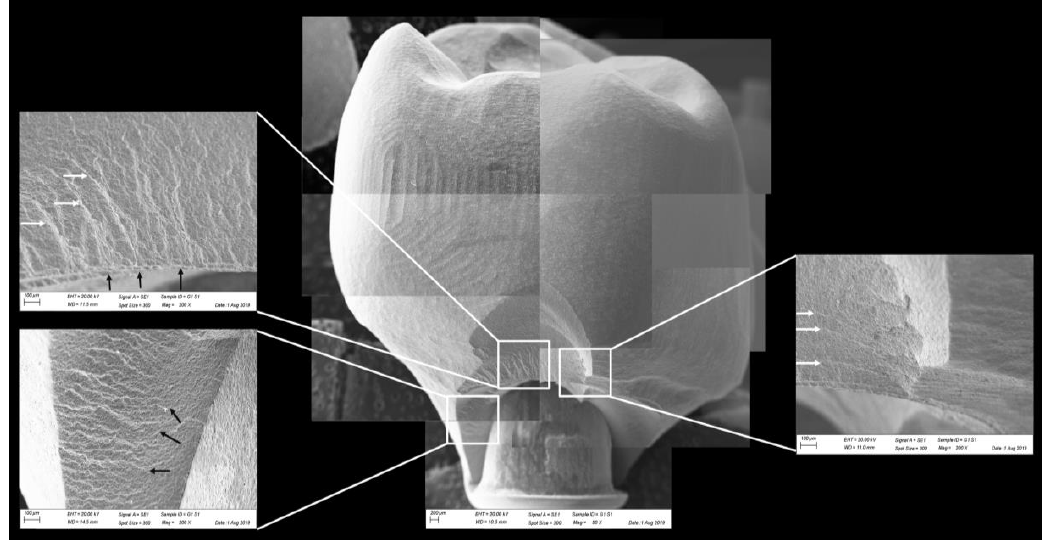
Figure 10. Fractographic analysis of a representative specimen from MP group. The failure originated in the cervical region and propagated to the top of the restoration. The white arrows indicate the hackle lines and the black arrows indicate the twist hackle marks.